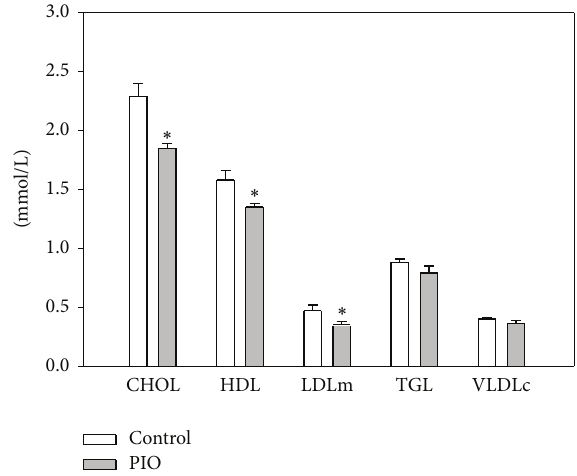
Figure 2: Effect of pioglitazone administration on plasma lipid profile in young SHRs. CHOL: cholesterol; HDL: high density lipoprotein; LDLm: low density lipoprotein (measured value); TGL: triglycerides; and VLDLc: very low-density lipoprotein (calculated value). Data represent mean ± SEM, 𝑛 = 7 . ∗ 𝑃 < 0.05 , PIO versus control.